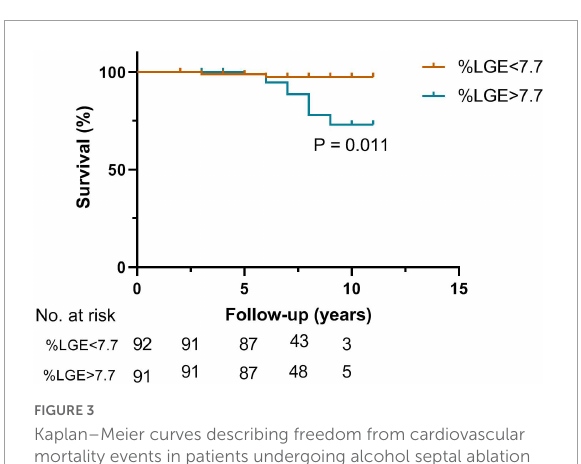
FIGURE3 Kaplan–Meier curves describing freedom from cardiovascular mortality events in patients undergoing alcohol septal ablation with an extent of LGE < 7.7% and ≥ 7.7% of LV